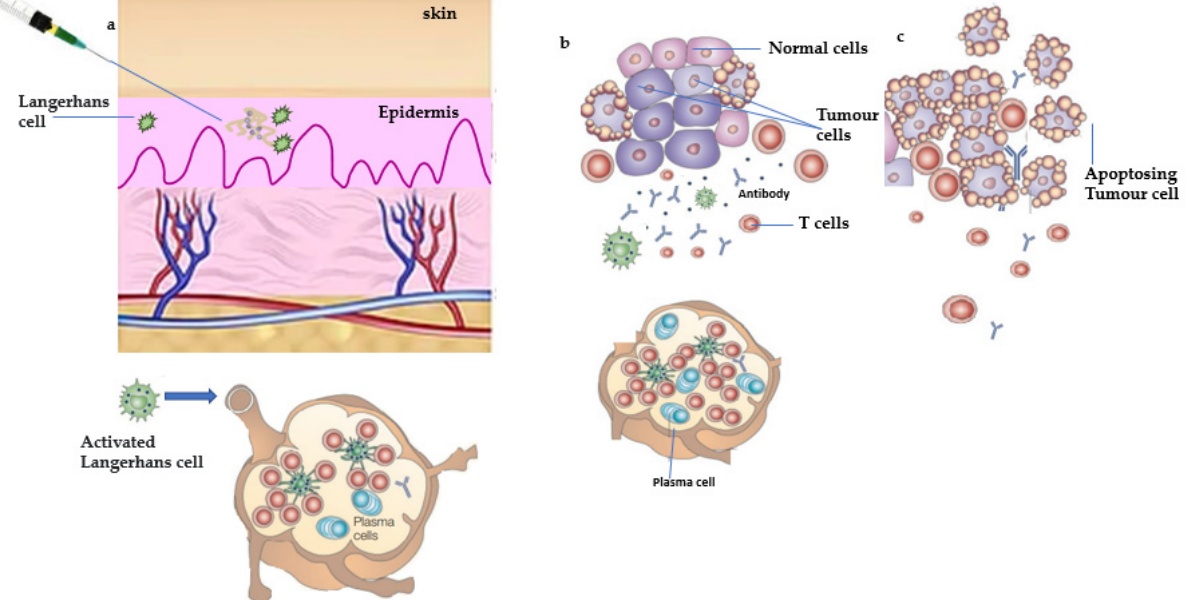
Figure 2 . Proposed mechanism of action of prophylactic vaccine. (a) Prophylactic vaccination is Figure 2. Proposed mechanism of action of prophylactic vaccine. ( a ) Prophylactic vaccination is used used to manipulate antitumor immune responses . Individuals who are at high risk of developing to manipulate antitumor immune responses. Individuals who are at high risk of developing tumors or tumors or have been diagnosed with premalignant changes in target tissues would receive have been diagnosed with premalignant changes in target tissues would receive prophylactic vaccines prophylactic vaccines prior to the occurrence of tumors . A vaccine based on antigens expected to be prior to the occurrence of tumors. A vaccine based on antigens expected to be expressed by the expressed by the anticipated tumor is administered in an immunostimulatory preparation ( with anticipated tumor is administered in an immunostimulatory preparation (with adjuvant) that can adjuvant ) that can activate Langerhans cells — epidermal dendritic cells ( DCs ). Activated Langerhans activate Langerhans cells—epidermal dendritic cells (DCs). Activated Langerhans cells transport cells transport tumor antigens to the draining lymph node, where they present antigens to T - cells . B - tumor antigens to the draining lymph node, where they present antigens to T-cells. B-cells are also activated, with the expected result of clonal expansion of tumor-specific T-cells and antibody production. This clonal expansion of effector cells is followed by the generation of a pool of memory cells specific for the tumor antigen/s over time. ( b ) If a tumor grows in the future, tumor antigens secondary immune response. This response will be distinguished by a large number of effector T-cells, a high titer of antibodies, and continuous activation of DCs at the tumor site, allowing for